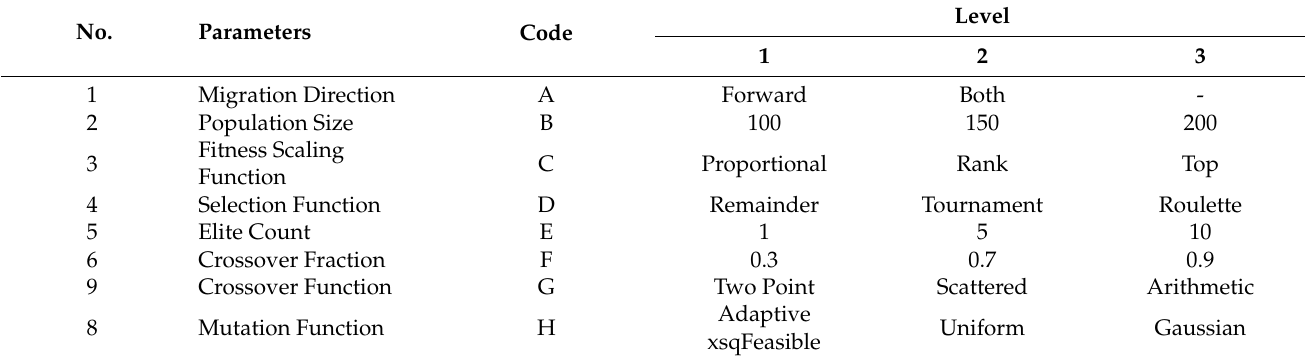
Table 1. Solver options and their experimental levels.